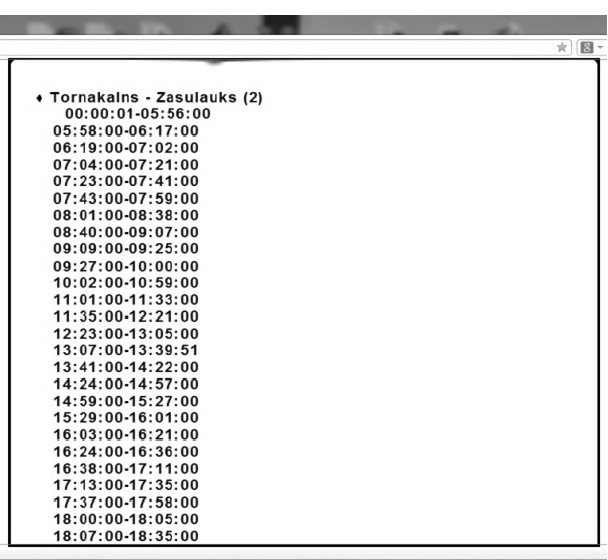
Fig. 7. All available